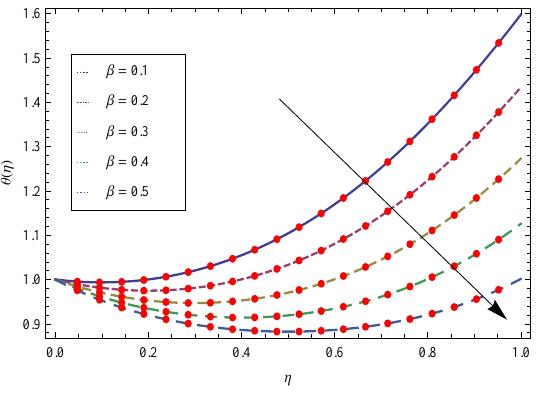
Figure 23. Shows the effect of β on f ( η ) , for h = − 0.7, λ = 1,kr = 0.5,Pr = 0.5,Ec = 0.5, Nb = 0.5, Nt = 0.6, β = 0.1 and Sc = 0.6.